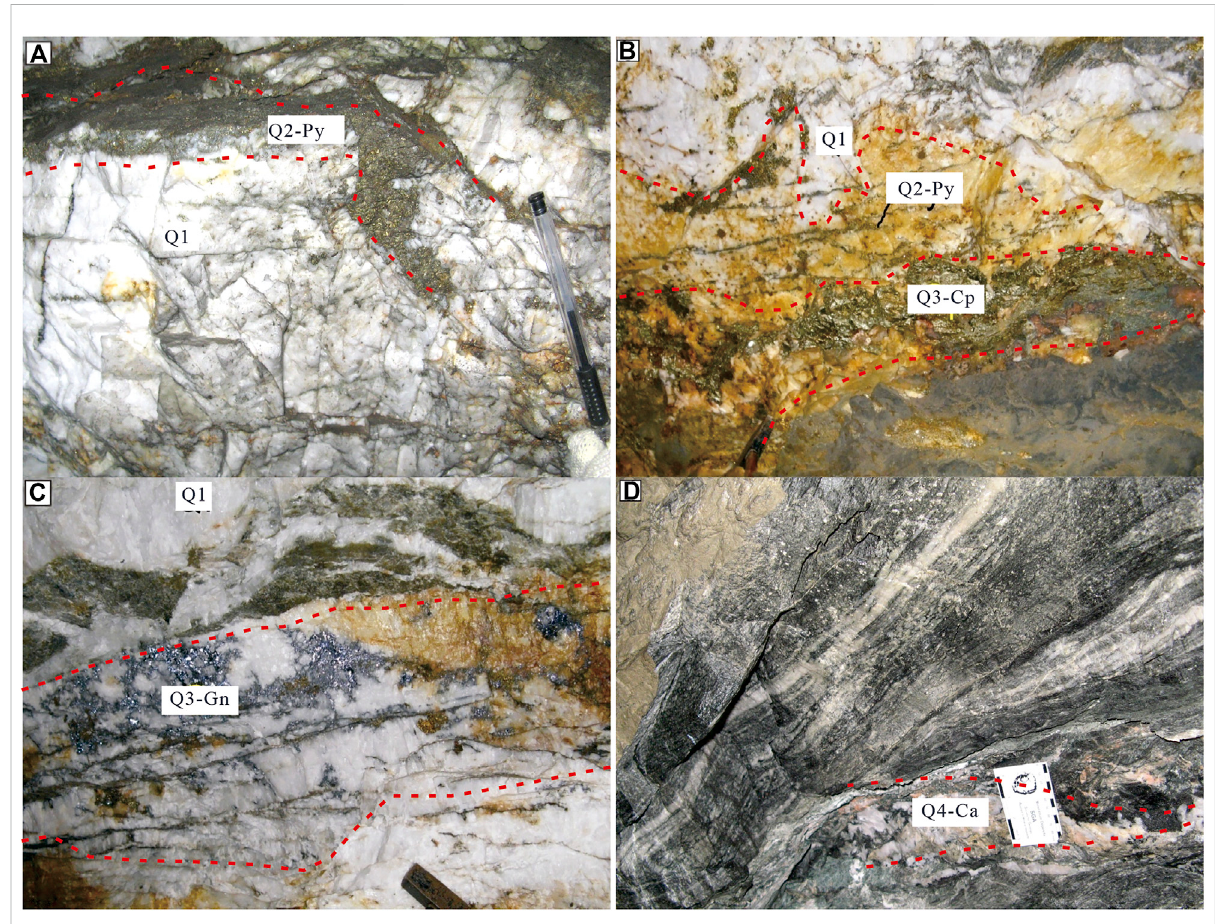
FIGURE 5 OccurrencesofquartzveinsintheDongtongyugolddeposit (A) -Quartz-pyritevein(Py-Q2)crosscutwhitequartzvein(Q1),at600 mlevel; (B) - Quartz-chalcopyrite veinlets(Q3-Cp)andPyrite-quartz vein(Q2-Py) fi lled alongthebottomofthe fi rststageofquartzvein(Q1),at600 mlevel; (C) - Quartz-galena (Q3-Gn) stockworks and veinlets fi lled along the fi rst stage of quartz vein (Q1), at 600 m level; (D) -Quartz and calcite veins in the mylonitized shear zone (Q4), at 600 m level. Qi- Quartz of stage i; Cp-chalcopyrite; Py-pyrite; Gn-galena;